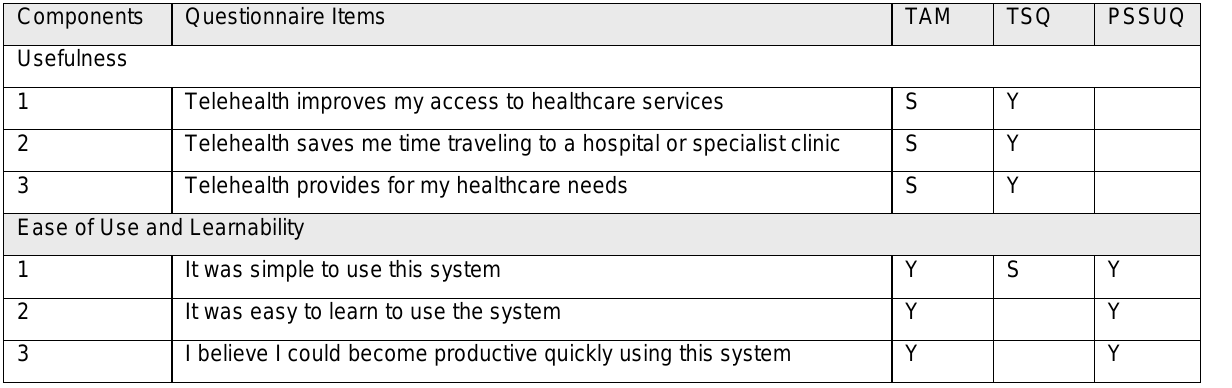
Table 1. Usability Components and Questionnaire Items and Their Source